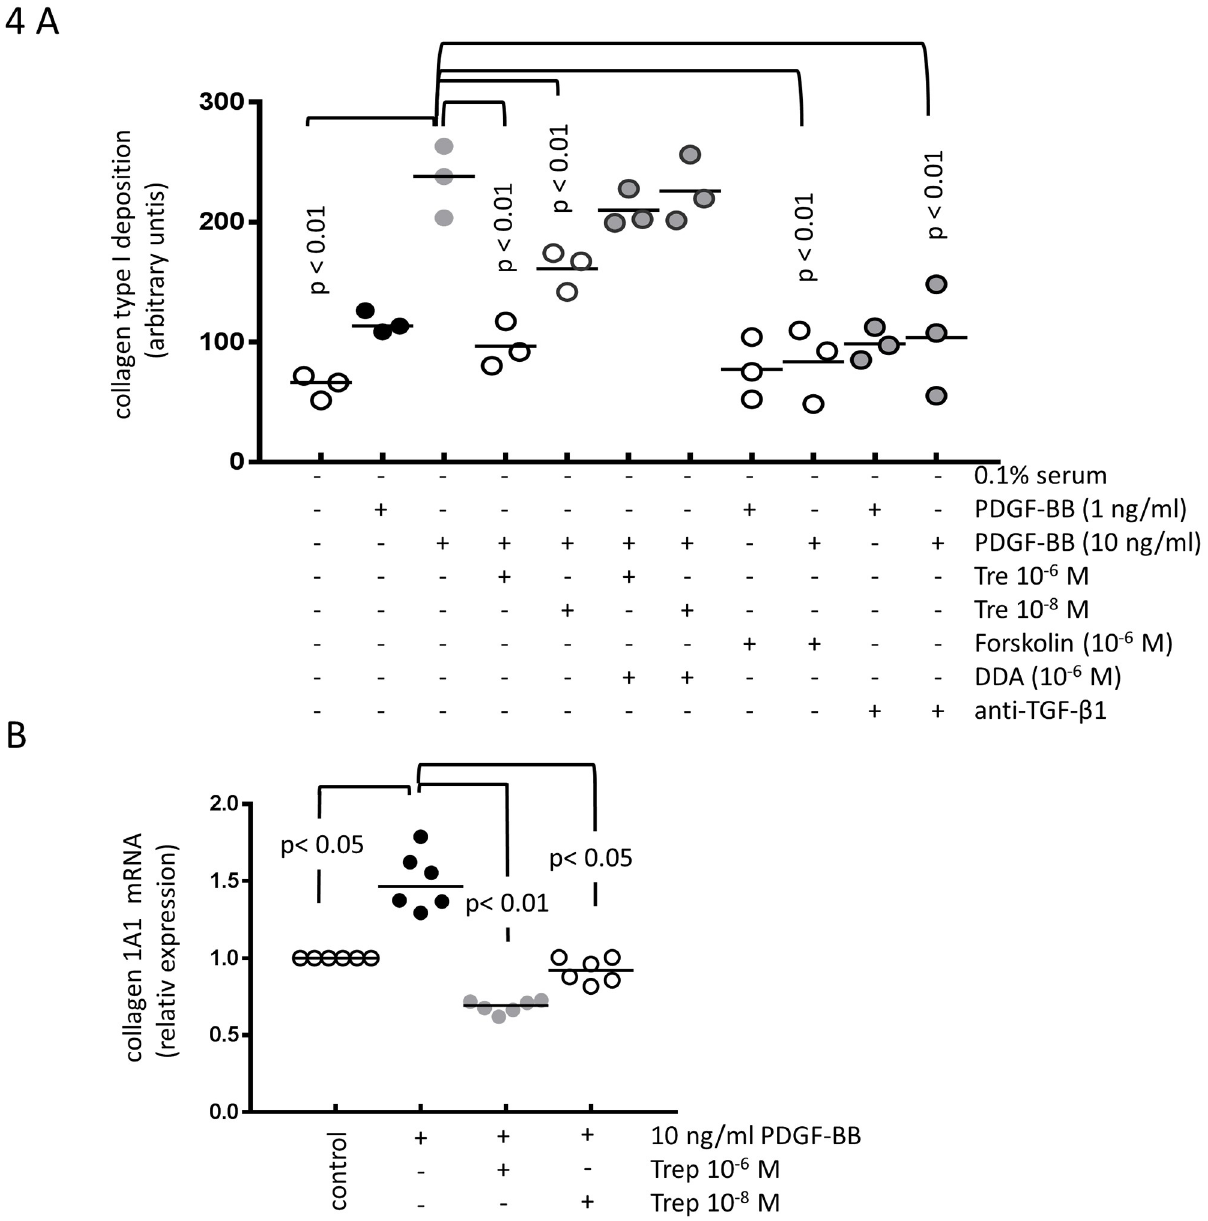
Fig 4. The inhibitory effect of treprostinil and the role of cAMP and TGF- β on PDGF-BB induced. (A) collagen type-I deposition (n = 3) and (B) de novo synthesis of COL1A1 mRNA (n =